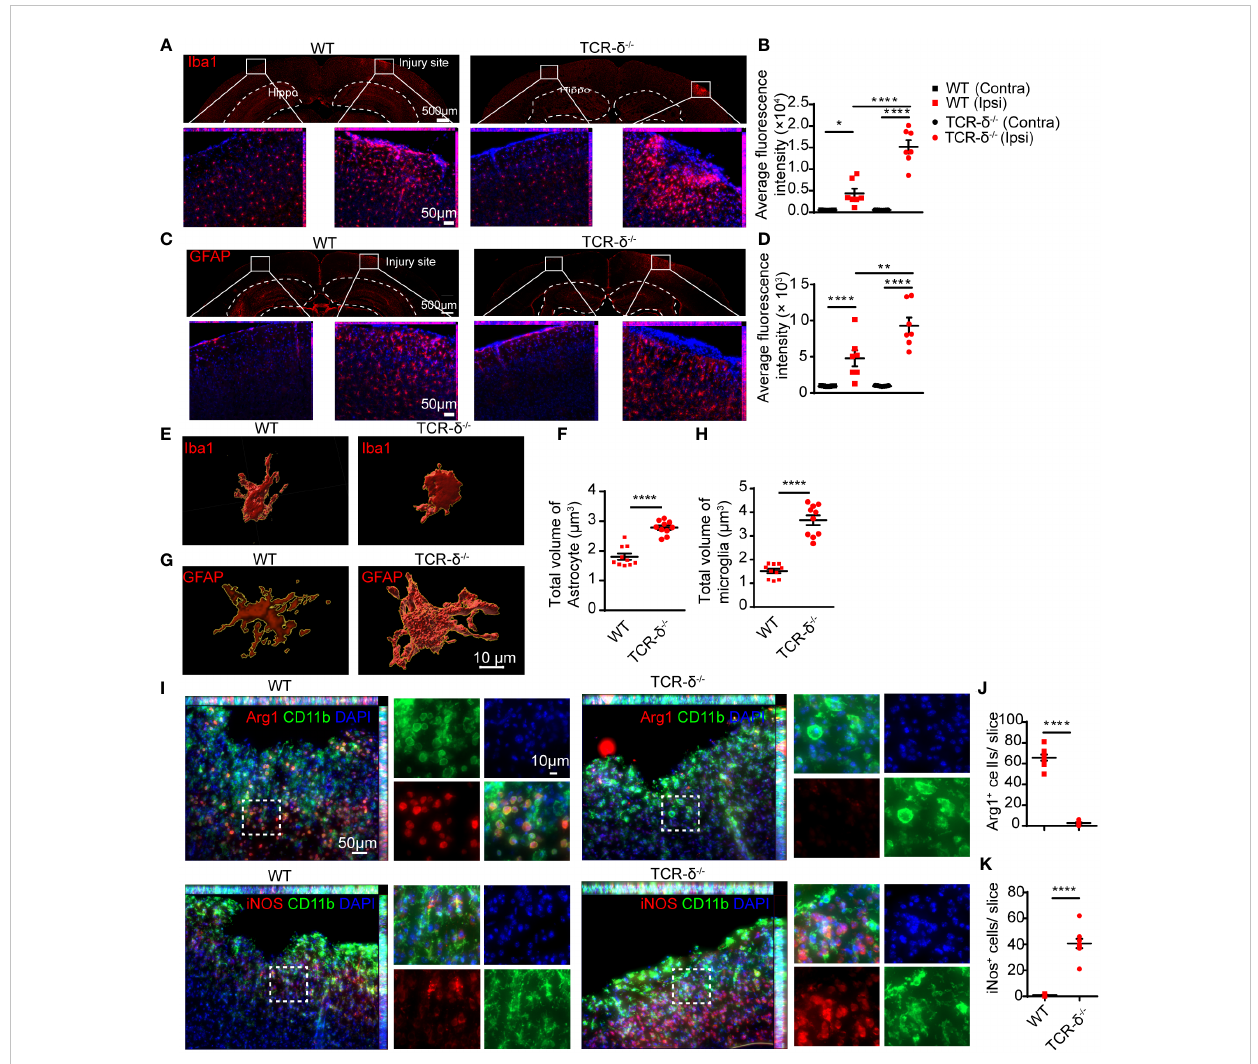
FIGURE 5 gd T cells de fi ciency increases glial response and macrophage polarization in the cortex after CMBs. Immuno fl uorescent staining of cortical sections from WT and TCR- d -/- mice at 5 dpi. (A, B) Anti-Iba1 immunostaining (red) shows increased active microglia surrounding the injury sites compared to the intact sides in both groups (A) , and the average fl uorescence intensity are signi fi cantly higher in TCR- d -/- mice compared to WT mice on the injury side (B) ; * P <0.05, **** P <0.0001; One-way ANOVA with Tukey ’ s multiple comparison; n ≥ 3 per group). (C, D) Similar increase of astrocyte response is identi fi ed in TCR- d -/- mice in anti-GFAP immunostaining (C) , statistical analysis of average fl uorescence intensity (D) ; ** P <0.01, **** P <0.0001; One-way ANOVA with Tukey ’ s multiple comparison; n ≥ 3 mice in each group). (E – H) Tridimensional reconstruction analysis show the signi fi cant increases of reactive microglia and astrocyte volumes in TCR- d -/- mice compared to WT mice, respectively (**** P <0.0001; Student ’ s t -test). (I – K) Anti-CD11b double immunostaining with anti- Arg1 or anti- iNOS discloses M2 and M1 macrophages in the peri-CMBs regions respectively (I) . Statistical analysis of cell densities shows a decrease of M2 (anti-in fl ammatory) macrophages (J) and an increase of M1 (pro-in fl ammatory) macrophages (K) in TCR- d -/- mice compared with WT mice (**** P <0.0001; Student ’ s t -test; n ≥ 3 mice in each group; DAPI counterstained nuclei in blue; Hippo, Hippocampus; Ipsi, ipsilateral side; Contra, contralateral